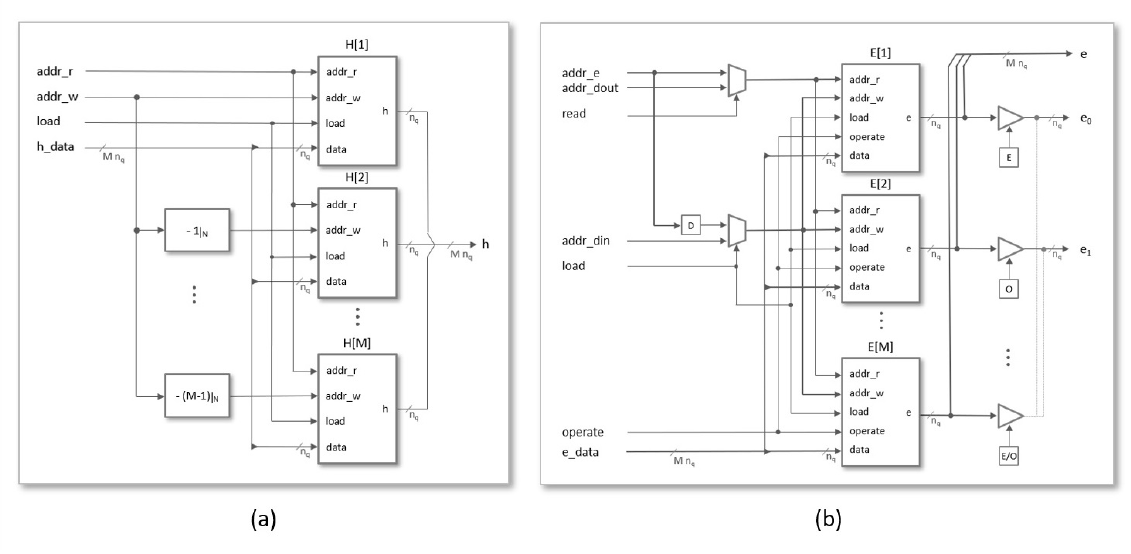
Figure 8. Memory structures used to store the coefficients of polynomials h ( x ) ( a ) and e ( x ) ( b